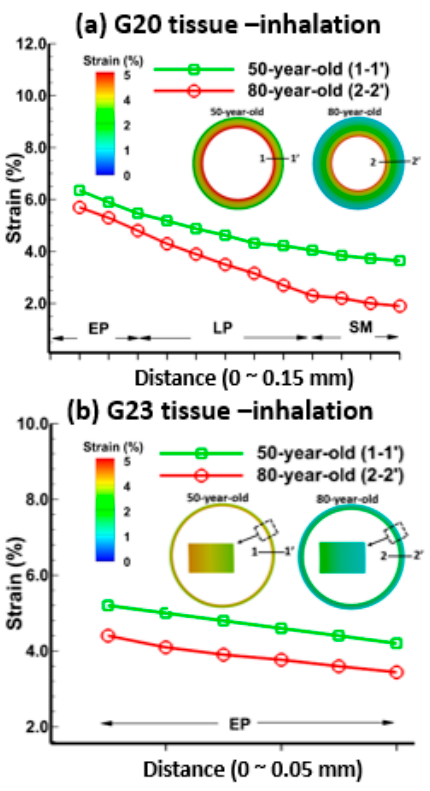
Figure 4. Tissue strain distributions during mid-point of inhalation (t = 0.2 s) for the 50-year-old and the 80-year-old at each layer—epithelium, lamina propria, and smooth muscle—of ( a ) the bronchiole (G20); and epithelium of ( b ) the alveolar sac